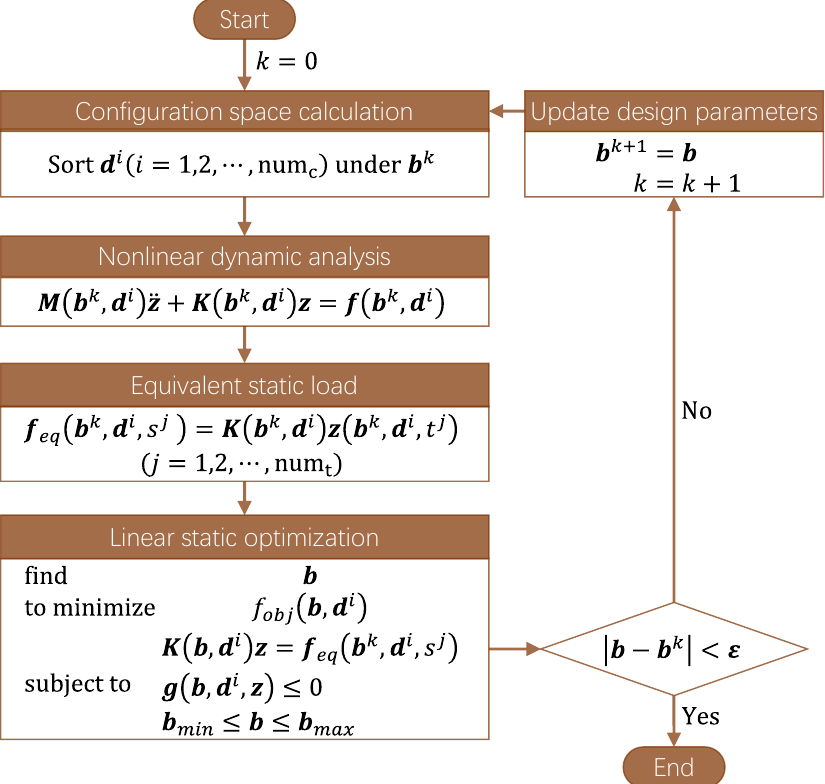
Figure 8. The procedure of equivalent static loads by adding mechanism configuration.